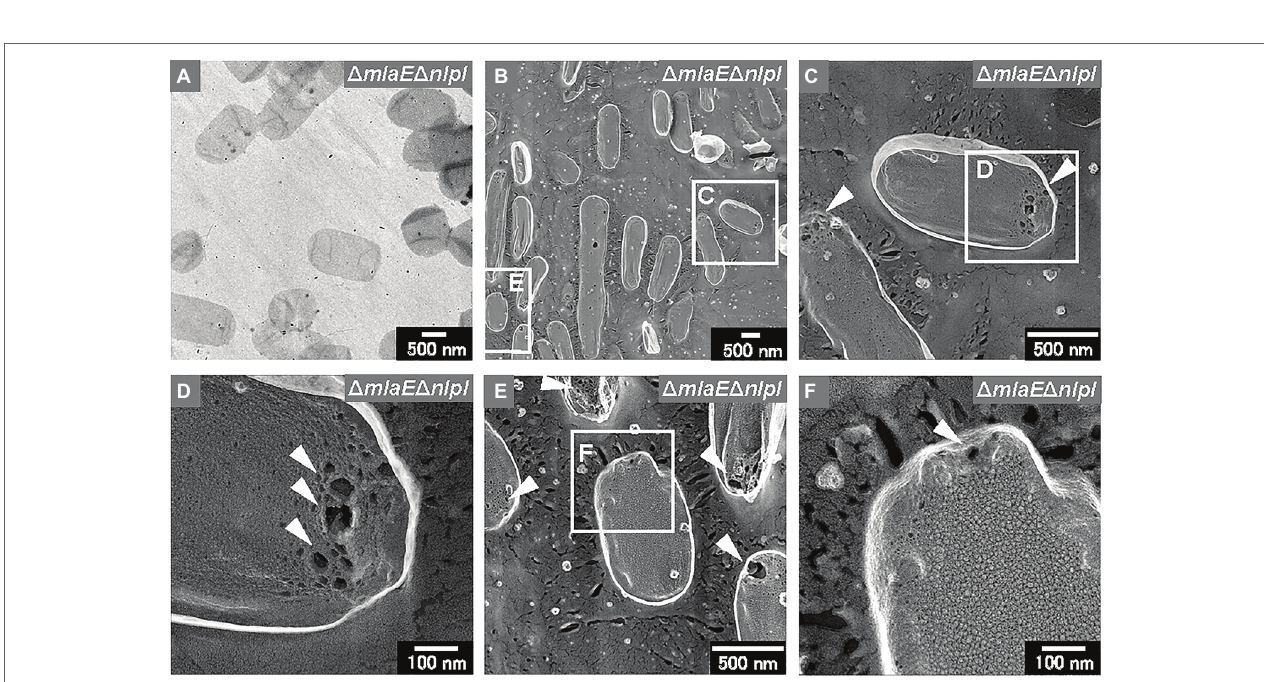
FIGURE 7 | Sacculi of the WT E. coli cells. (A) The TEM image of the sacculi stained with uranyl acetate. (B–F) The surface structures of the sacculi were visualized by QFDE-EM.